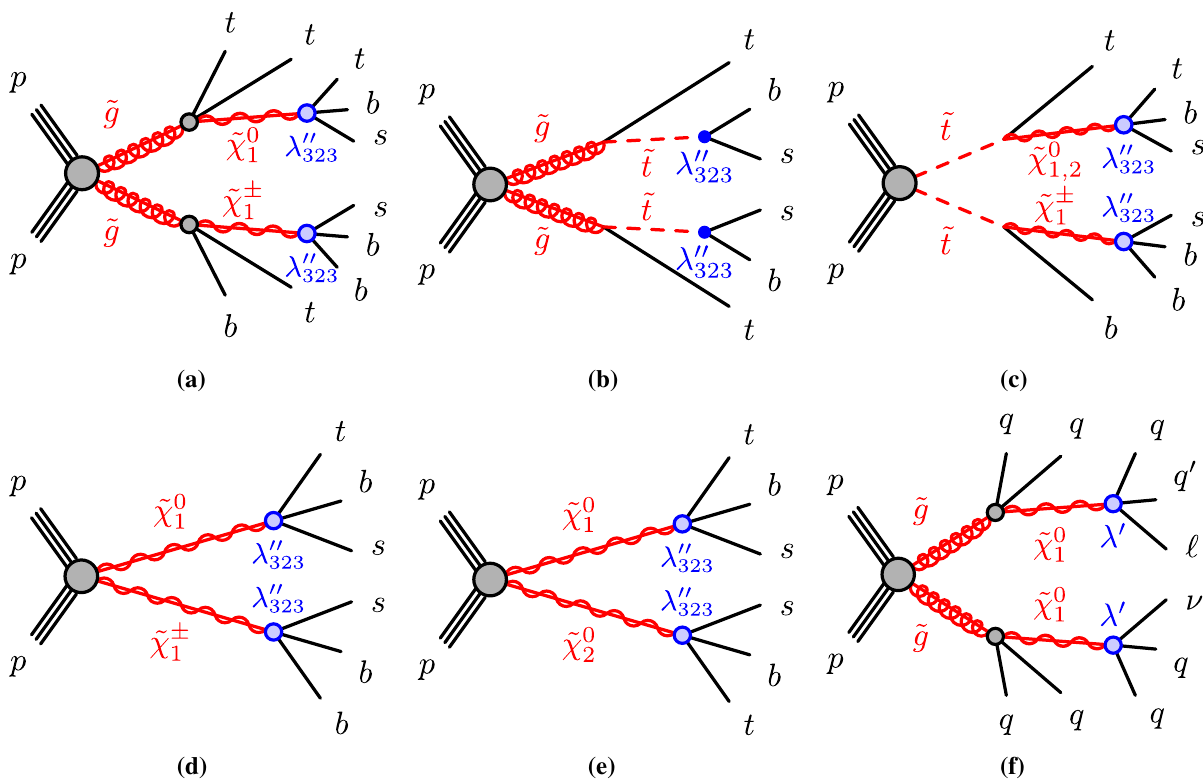
Fig. 1 Examples of signal diagrams for the simplified RPV models considered in this article. Cases where both of the gluinos (or the stops) decay in the same way are also considered, and ˜ χ